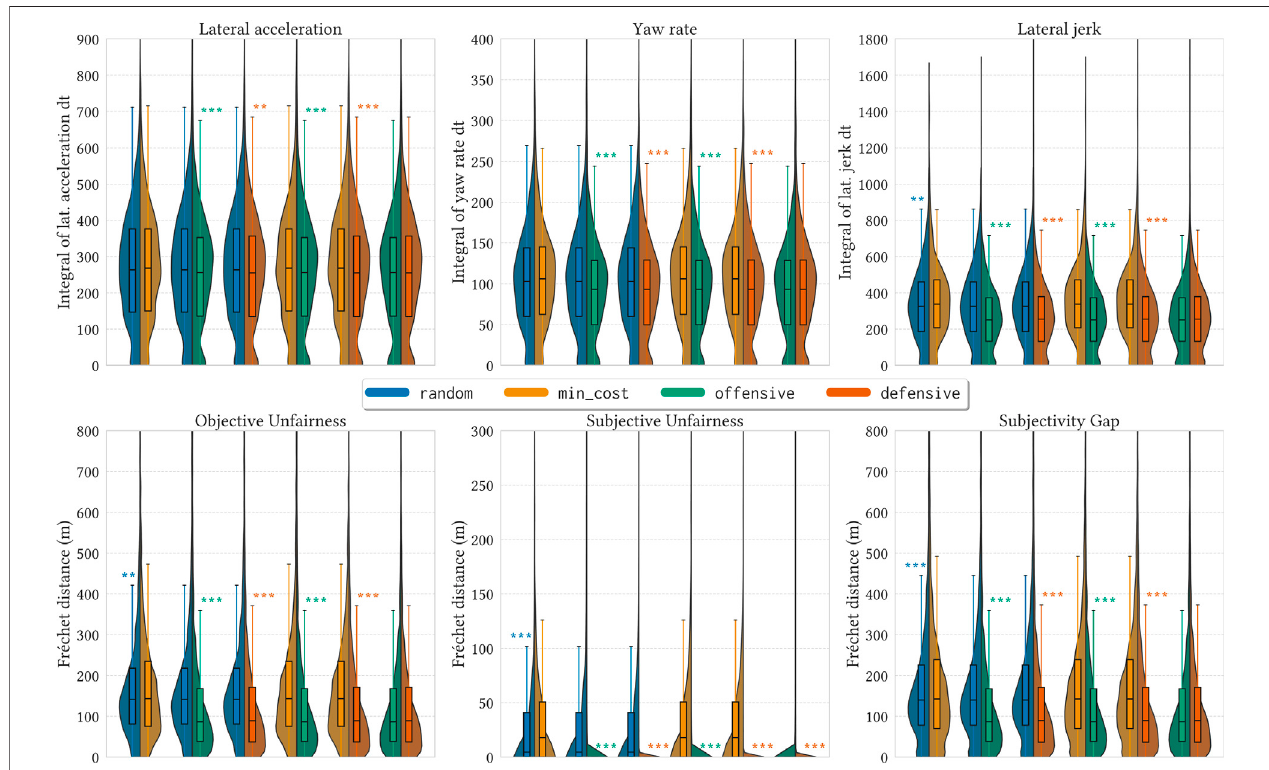
FIGURE 8 | Violin plots of aggregated data of 100 full simulations with a fi xed combined privacy budget 2 g = 60. Each strategy is shown in a different color. We performpairwisestatisticaltwo-sidedandone-sidedStudent ’ st-testsbetweendistributionstocheckiftheydiffersigni fi cantly,andifso,whichonepresentslowervalues ((*) p < .05; (**) p < .01; (***) p < .001). The top row shows an aggregation of all agents ’ simulation metrics ( n = 1,600 per strategy), where lower is indicative of a more comfortable ride. We plot the curves for measurements of lateral acceleration, yaw rate, and lateral jerk for all agents. Each data point in the top plots is the area underthe curve forthat metric(obtained via integration).Thebottom plotsshow values ofobjective unfairness ( Ω ),subjectiveunfairness( Ω p )and the subjectivity gap( l S ), measured as the Fréchet distance of the corresponding trajectories ( n = 32,000 per strategy). Higher values mean that the nominal/subjective trajectories differed more from the compared subjective/objective trajectories. Lower values are indicative of more agreement between trajectories.